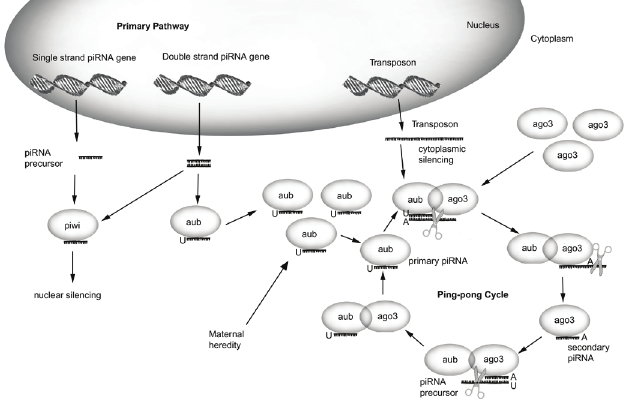
Figure 2. piRNA biogenesis pathways (Abbreviations: Aubergine: aub, Argonaute: ago, Adenine: A, Uridine: U)